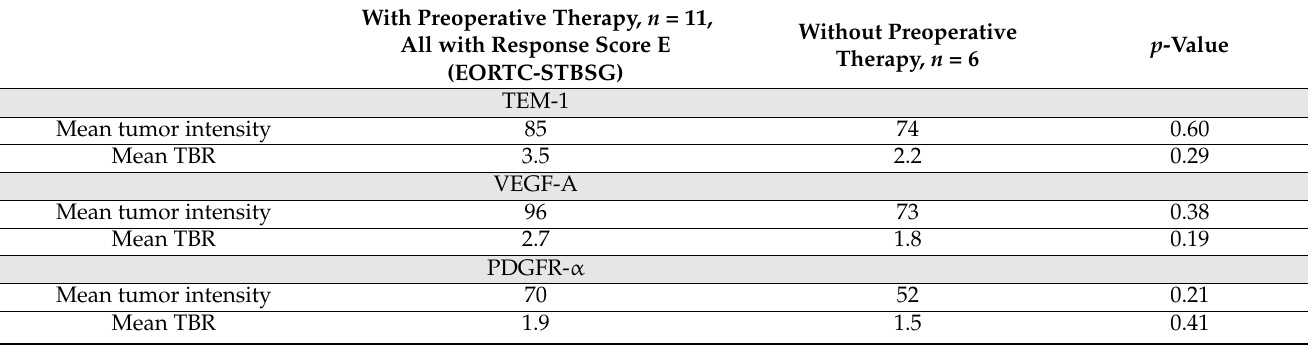
Table 2. Intensity scores and tumor-to-background ratios of TEM-1, PDGFR- α , and VEGF-A catego- rized by preoperative